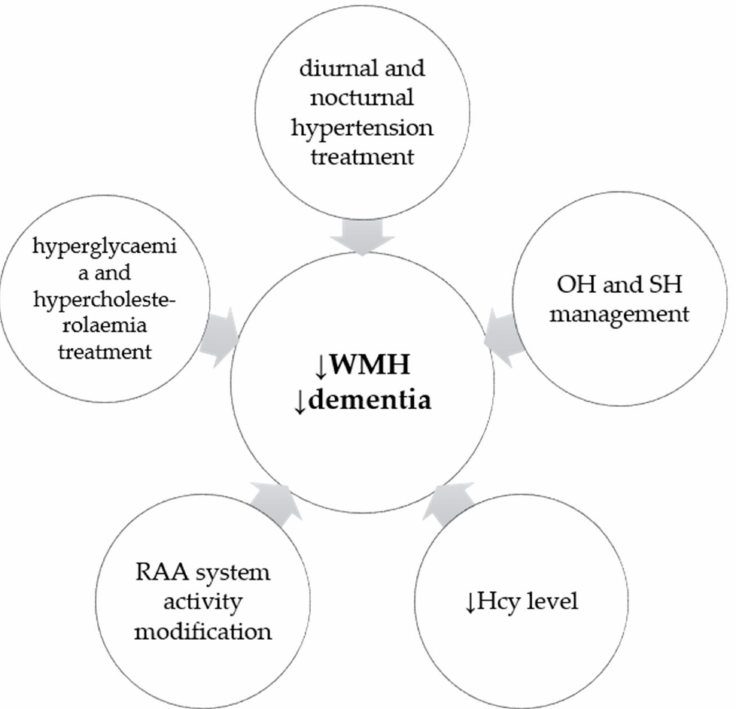
Figure 2. Possible measures decreasing the risk of developing WMH, and/or dementia, in Parkinson’s